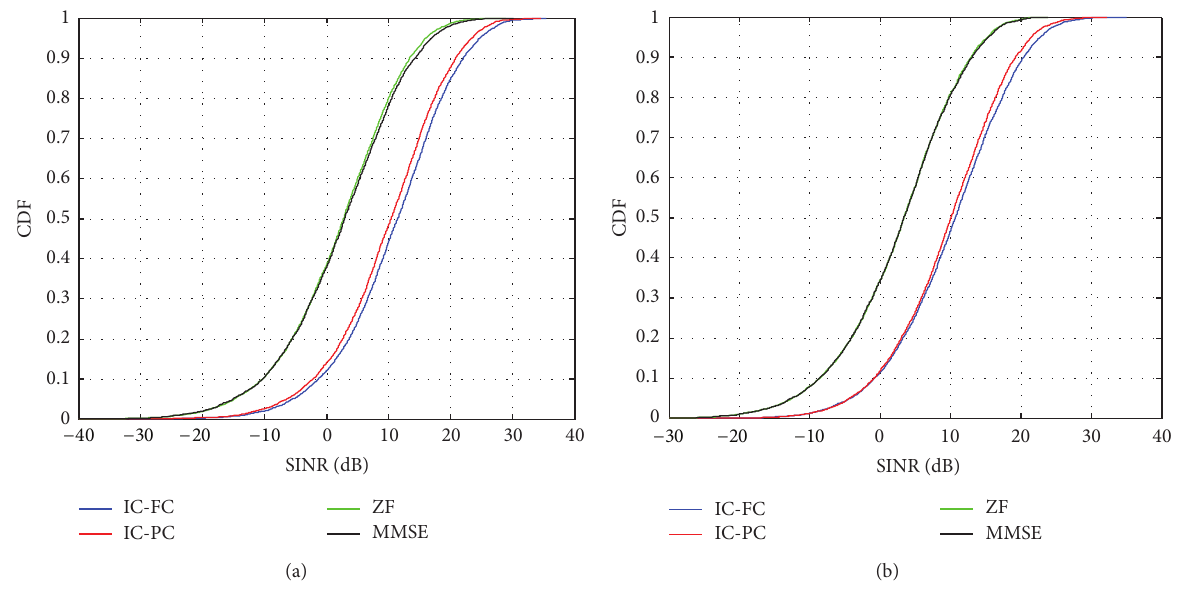
Figure 3: System level results of receive SINR CDF for multiple picocells scenario, for two cases: (a) 𝑛 𝑀 = 4 , 𝐾 = 4 , 𝑟 = 1 ; (b) 𝑛 𝑀 = 4 , 𝐾 = 4 , 𝑟 = 2 .